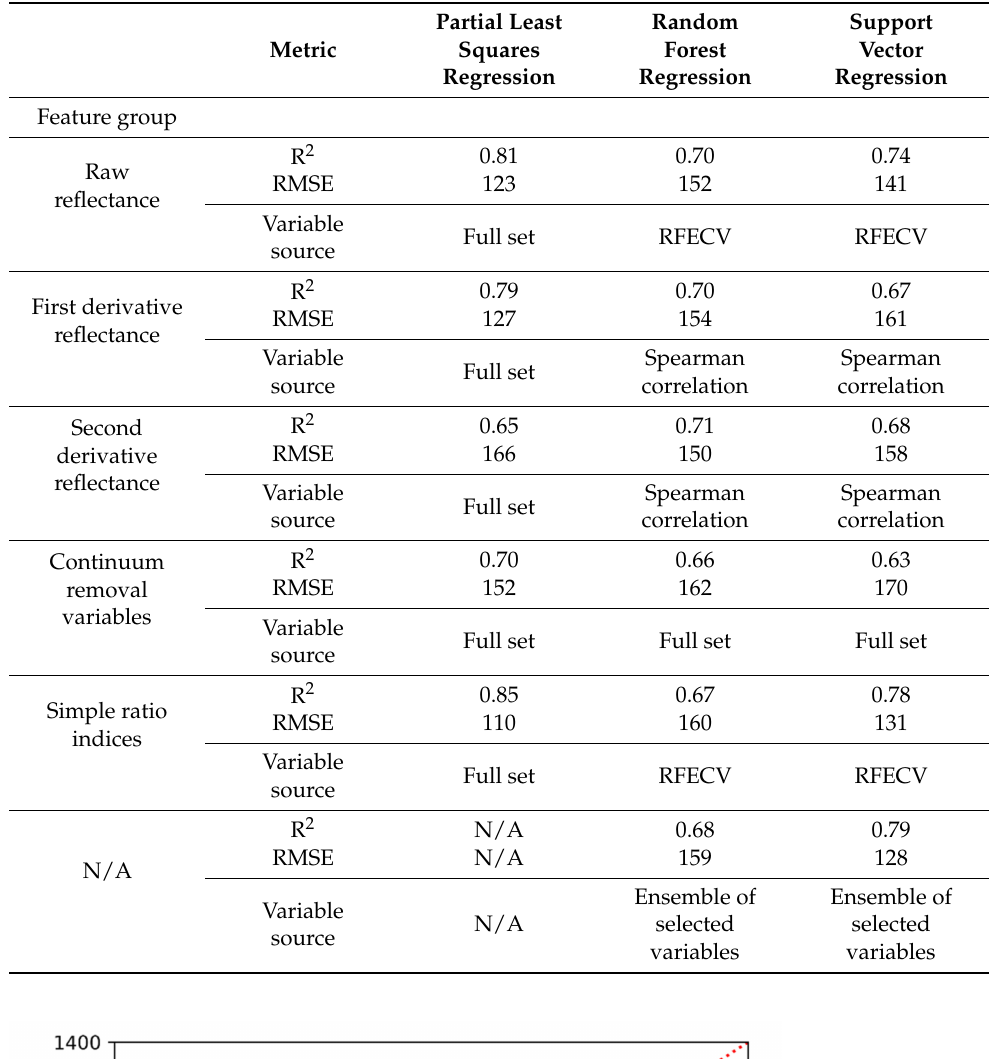
Table 7. Results of modeling performance on the test dataset.